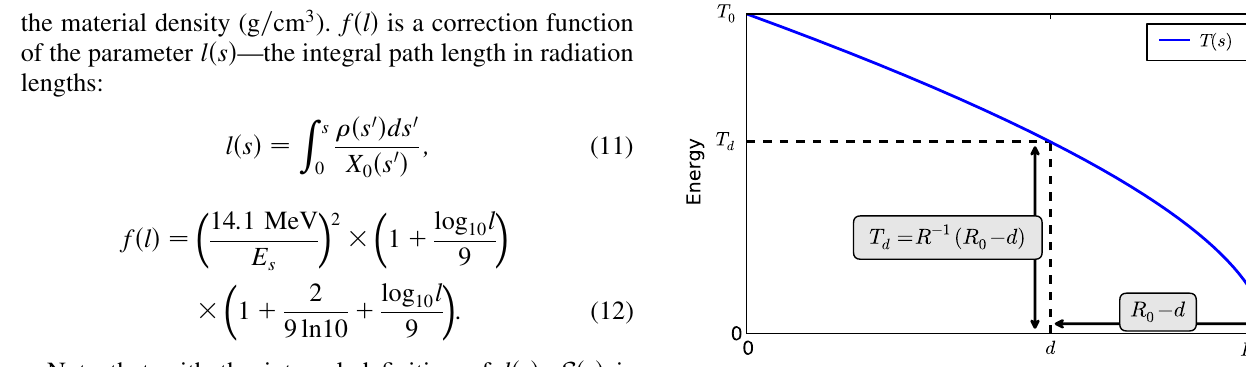
(cid:2) d and the beam 0